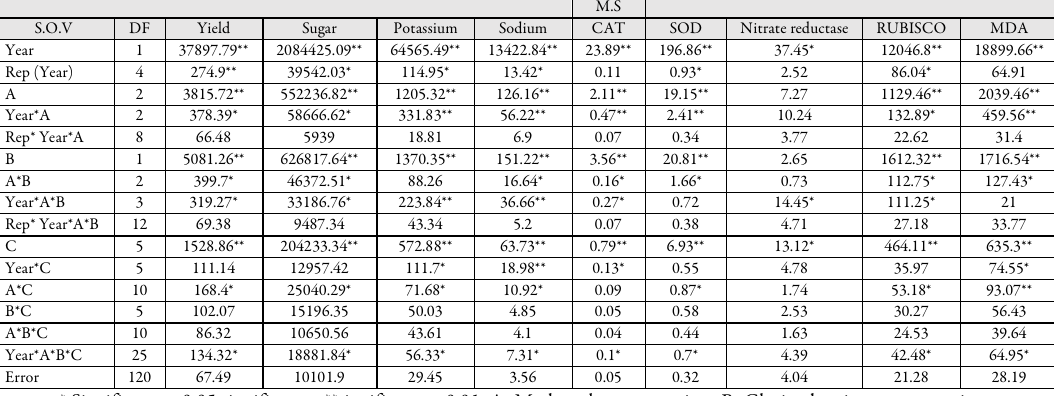
Table 3. Analysis of variance for yield, sugar, potassium, sodium, CAT, SOD, nitrate reductase, rubisco, MDA